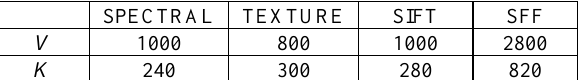
Table 1. Optimal V and K values for the different feature strategies with the UC Merced dataset